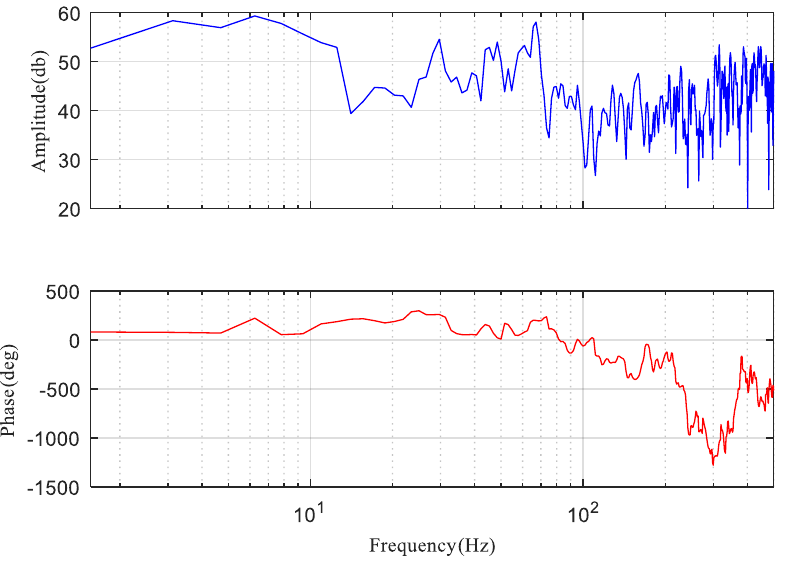
Figure 8. Frequency response of the test bench with acceleration time of 0.5 s.